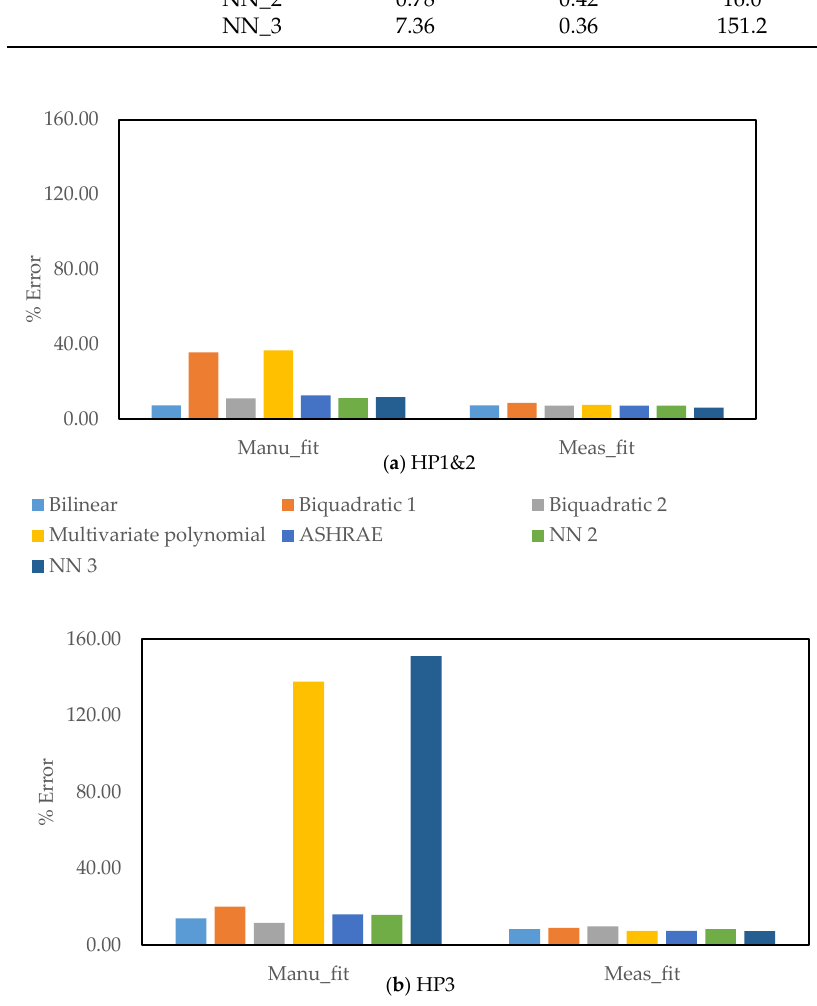
Figure 5. Testing error of ( a ) HP1&2; and ( b ) HP3.